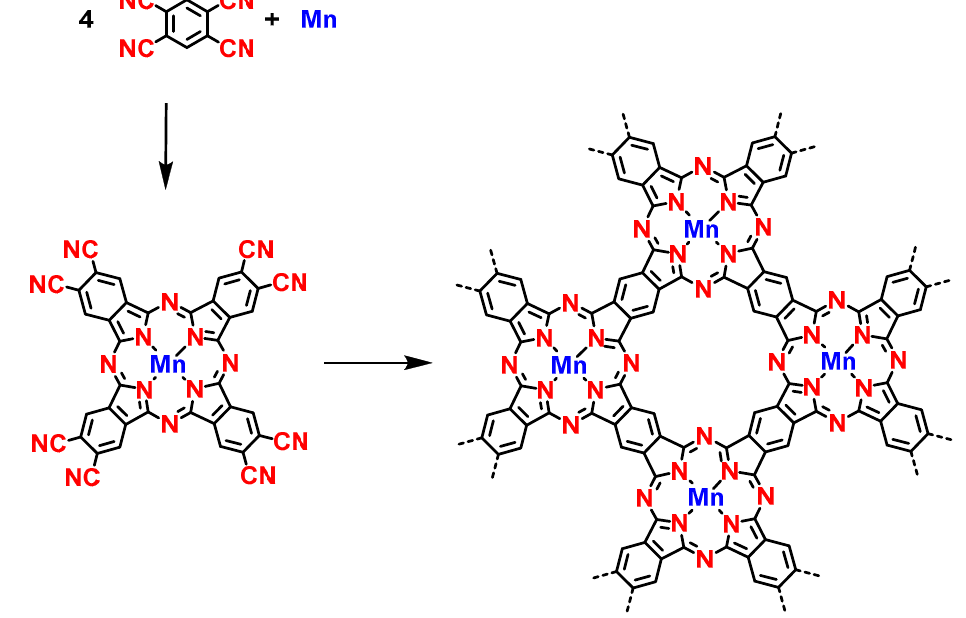
Figure 16. Sequential growth of the phthalocyanine-based polymer.